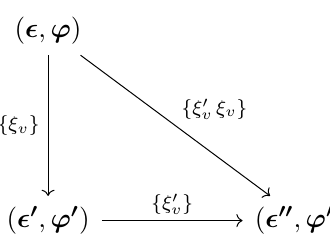
} coincides with v